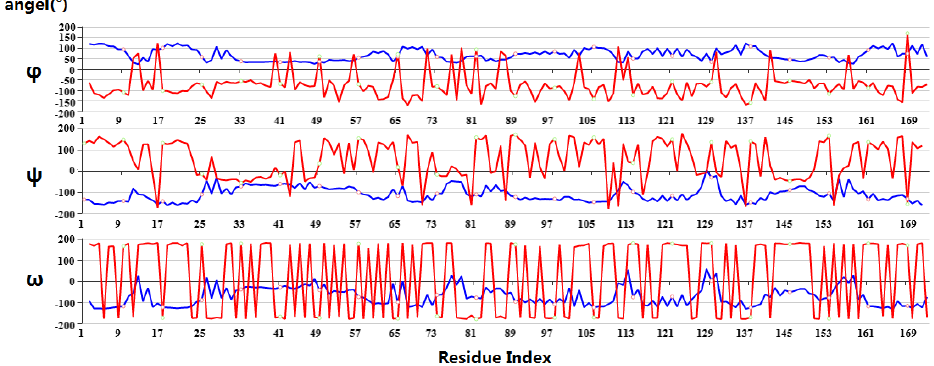
Figure 6. The line chart shows the predicted structure ( blue ) and actual structure ( red ) of a certain protein chain at angles φ , ψ , and ω , respectively.